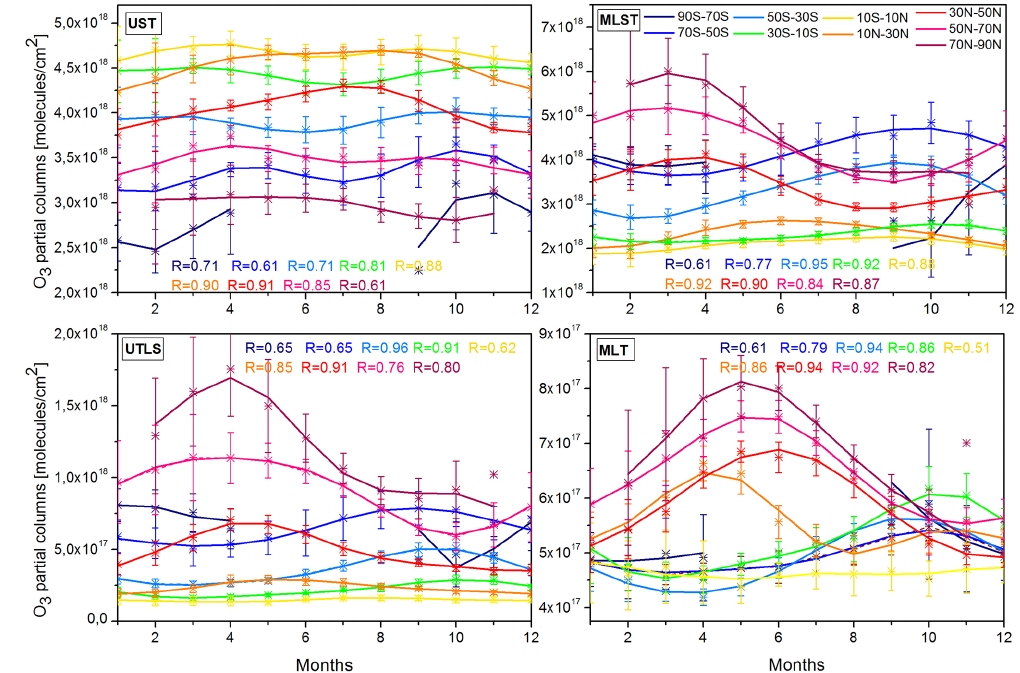
Figure 7. Monthly medians of measured (scatters) and of fitted (line) IASI O 3 columns averaged over the period 2008–2013, for the UST, MLST, UTLS and MLT layers and for each 20 ◦ latitude band (colour scale in the top-right panel). The fit is based on daily medians. Error bars give the 1 σ standard deviation relative to the monthly median values. Correlation coefficients ( R ) between the daily median observations and the fit are also indicated. Note that the scales are